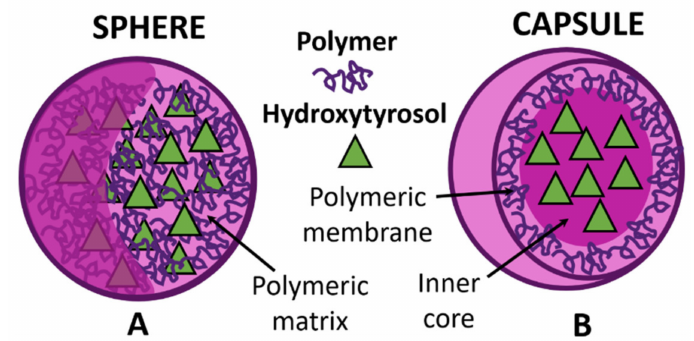
Figure 5. Schematicstructureofspheres( A )andcapsules( B